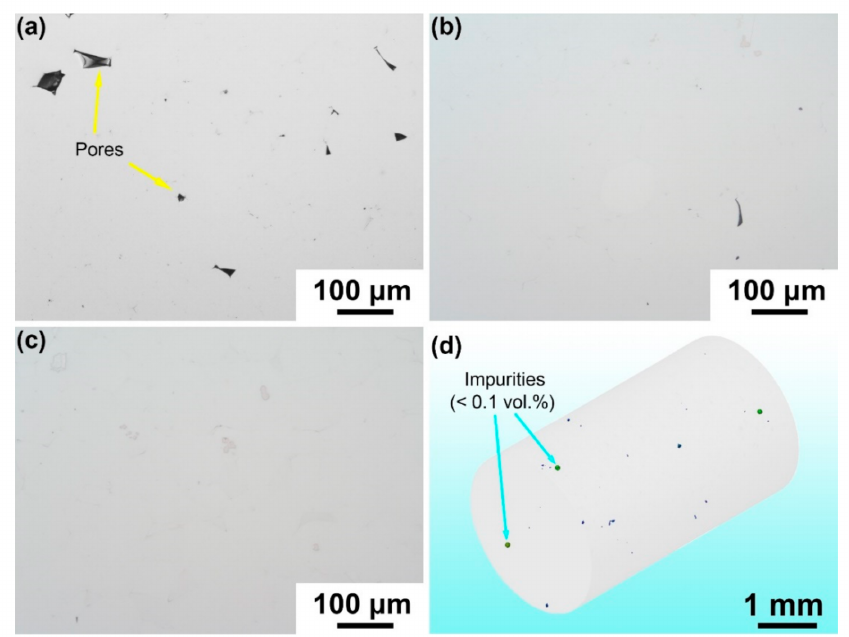
Figure 5. Microstructure of the Zr 48 Cu 36 Ag 8 Al 8 BMGs hot pressed at ( a ) 743 K, ( b ) 753 K, and ( c ) 758 K; ( d ) µ -CT (computed tomography) reconstruction of the Zr 48 Cu 36 Al 8 Ag 8 powder hot pressed at 753 K showing minor impurities but no